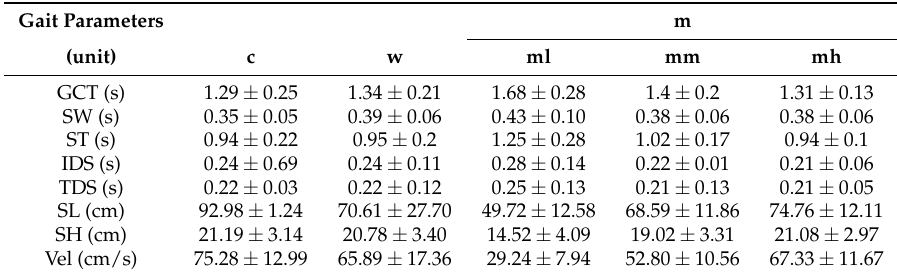
Table 4. Mean and standard deviation of gait parameters for Parkinson’s disease (PD) subjects walking without assistance (c), with conventional walker (w), and with motorized walker (m) at low (ml), medium (mm), and high (mh) speed cues.